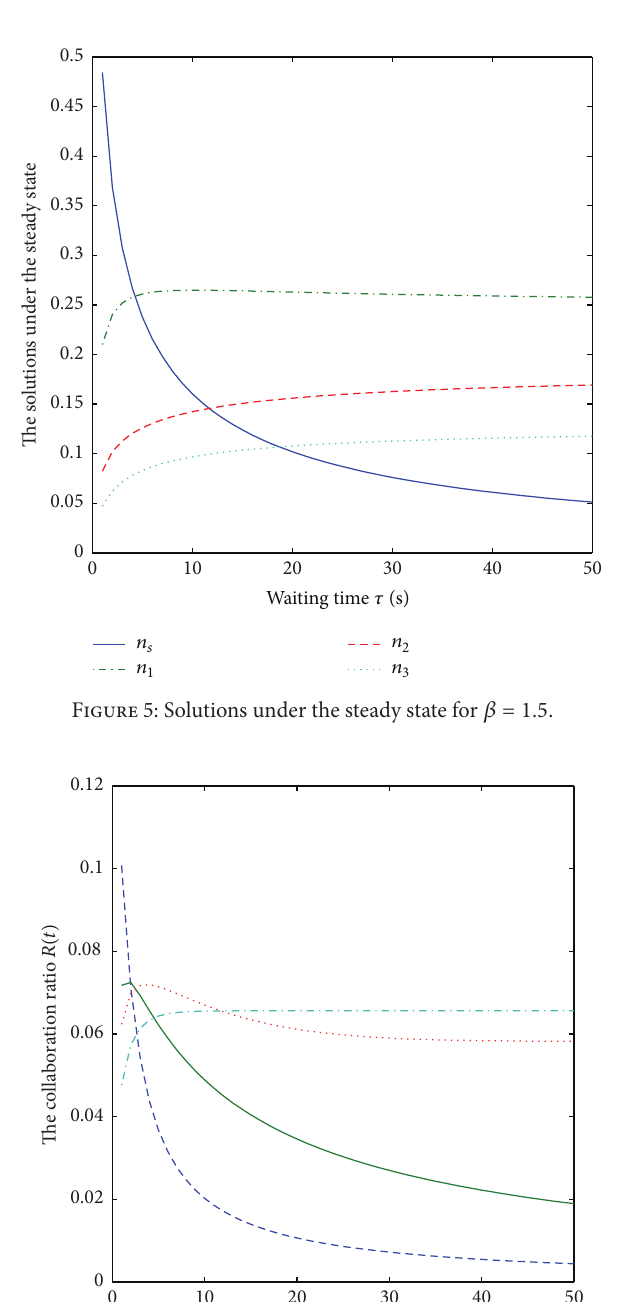
robot collective behaviors represents the transition between different states of robots. Each dynamic variable in the mathematical model corresponds to the number of robots in states. The dynamic characteristics of robot collective behaviors are investigated based on the macro mathematical model. This paper formulates the model as a set of rate equations and presents numerical solutions to